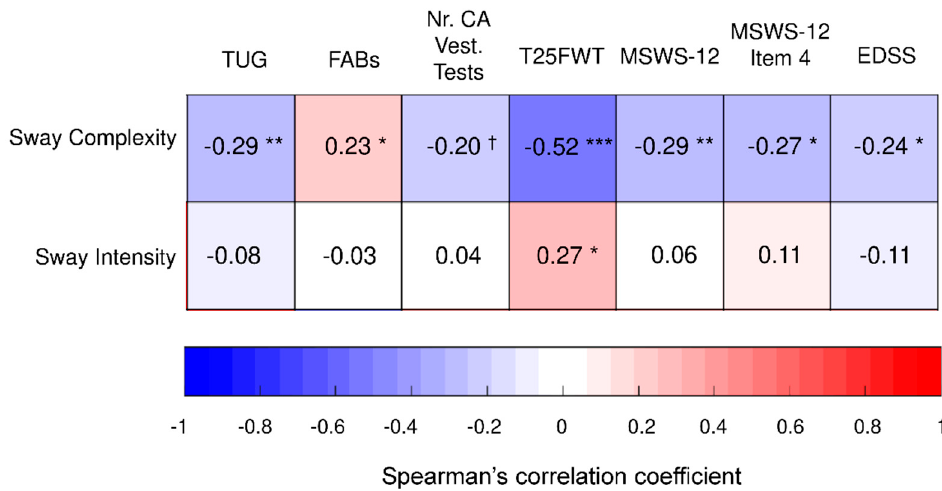
Figure 4. Spearman’s correlation coefficient between ImRomberg components (sway complexity and sway intensity) and clinical measures in PwMS. *** p < 0.001, ** p < 0.01; * p < 0.05; † p < 0.10. TUG: timed up and go; FABs: Fullerton advanced balance scale—short; Nr. CA Vest. Tests: number of clinically abnormal vestibular tests (i.e., standing on foam with eyes closed, turning 360 ◦ left and right, walking with head turns); T25FWT: timed 25 foot walk test; MSWS-12: twelve-item multiple sclerosis walking scale; EDSS: expanded disability status scale.